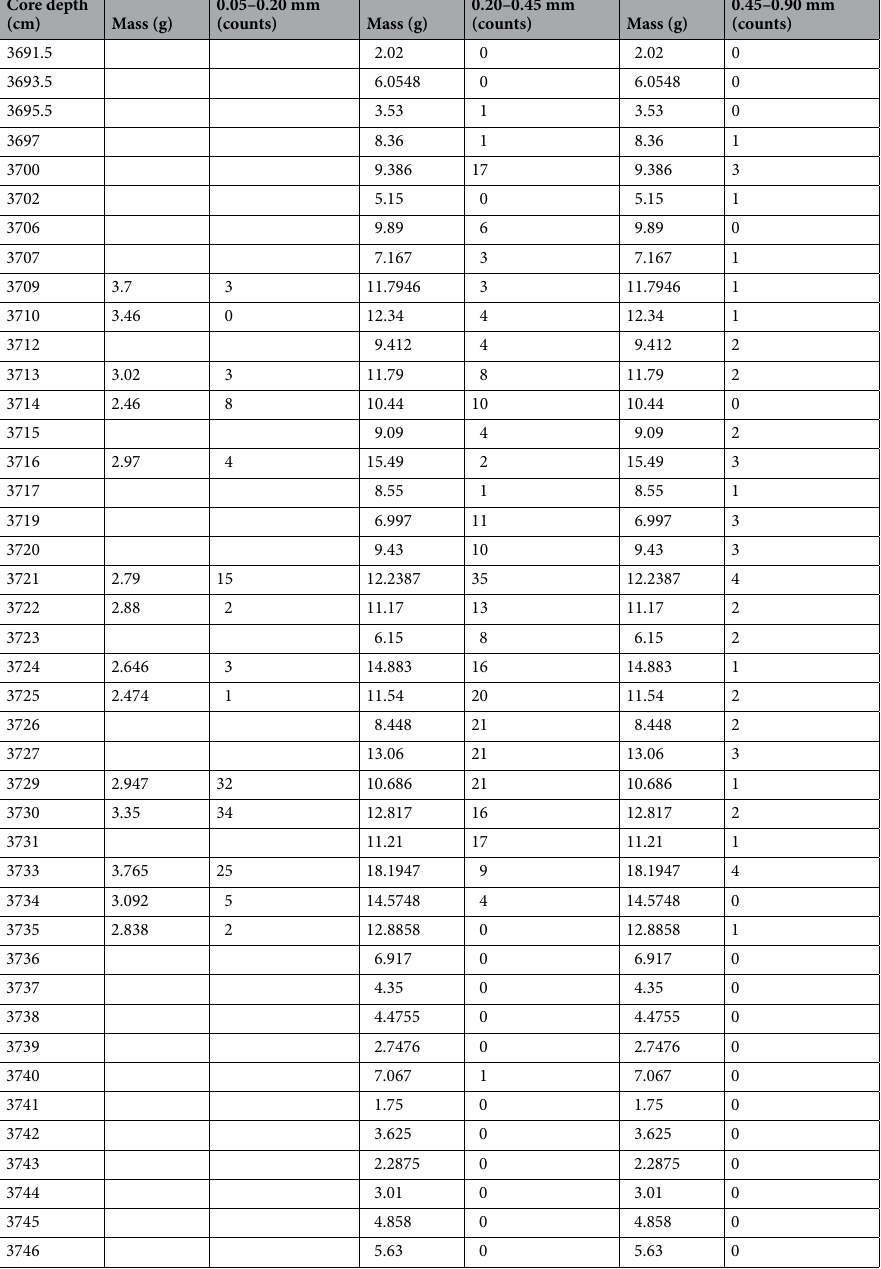
Table 2. Core MD90-0961 total microtektite counts, regrouped into three size